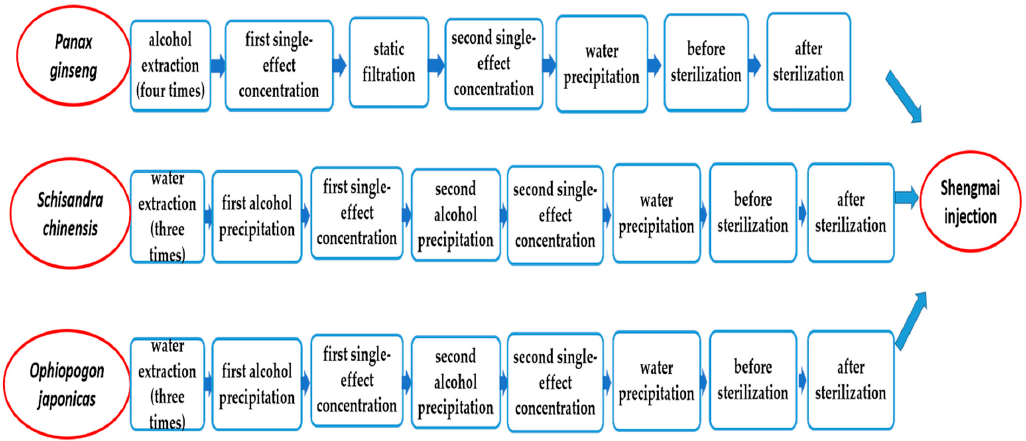
Figure 3. The process flowchart of SMI manufacture.